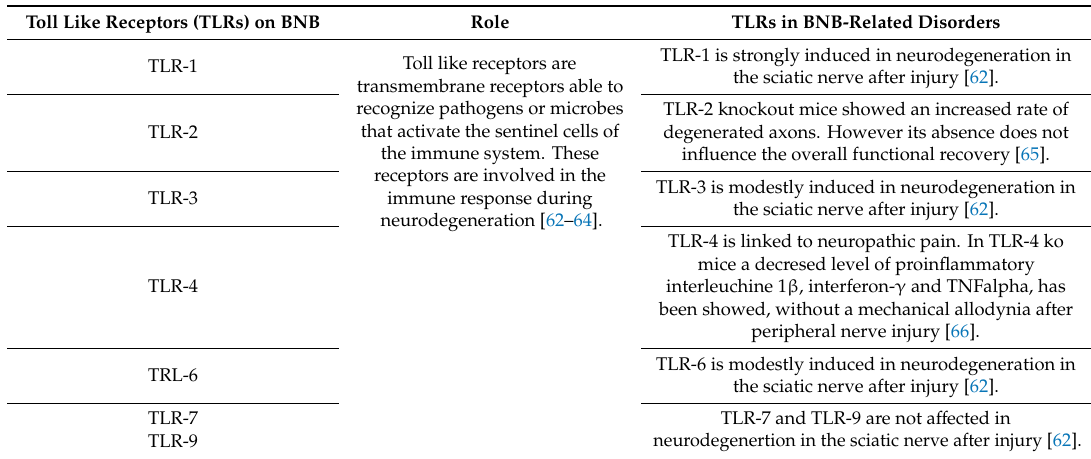
Table 3. TRLs and